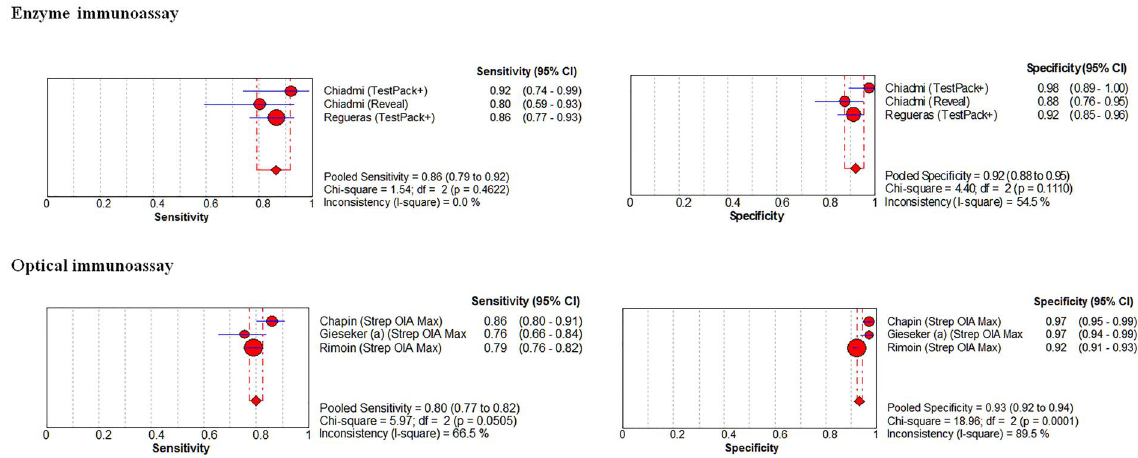
Figure 4. Pediatric strata, forest plots for enzyme immunoassay (EIA, top panels) and optical immunoassay (OIA, bottom panels) methods to diagnose group A streptococcal pharyngitis, higher study methodological quality.